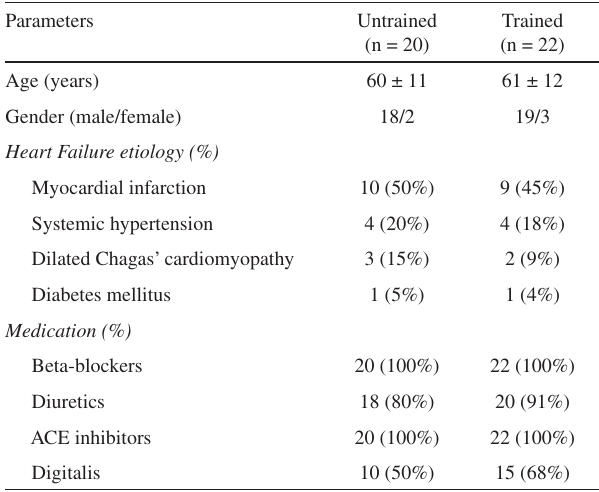
Table 1 - General and clinical characteristics of subjects in the